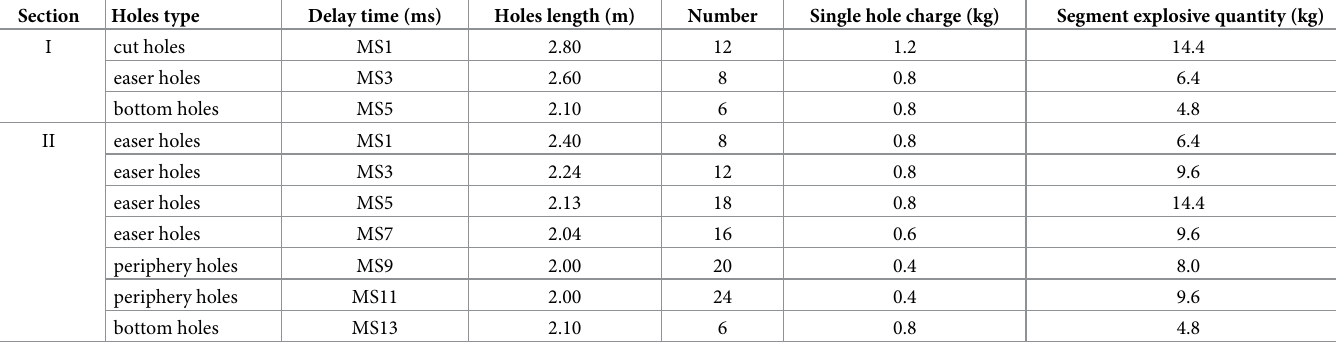
Table 1. Blasting parameters using non-electrical